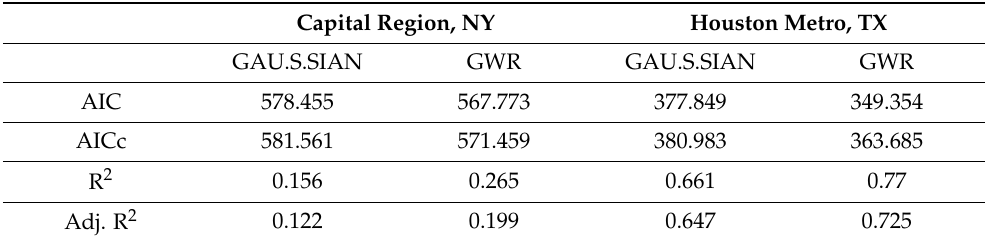
Table 3. Model summaries of the Gaussian global model and local GWR in both regions. Capital Region, NY Houston Metro, TX GAU.S.SIAN GWR